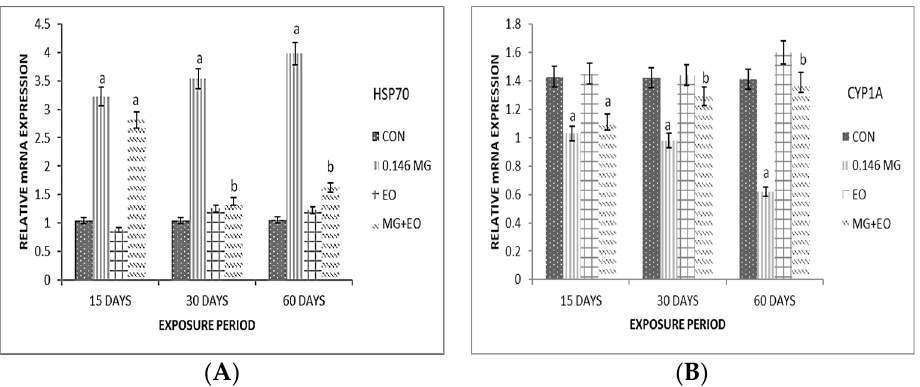
Figure 6. Relative expression of HSP70 and CYP1A in relation to 18S in C. carpio exposed to malachite green and E. officinalis for 15, 30 and 60 days. ( A )—HSP70 gene expression; ( B )—CYP1A gene expression. Abbreviations: CON: control; 0.146 MG: 0.146 mg/L MG; EO: Emblica officinalis ; MG + EO: 0.146 mg/L MG + E. officinalis . “a” indicates significant ( p < 0.05) change in groups (II, III, IV) compared to control group, while “b” indicates significant change compared to the MG treatment (group II) in the amelioration group (group IV) ( n = 9).